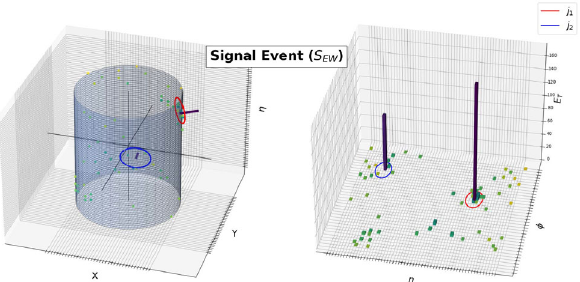
Fig. 2 Same as Fig. 1, but for a prototype background event originated from a Z (ν ¯ ν) + jets production, where the jets originate from QCD